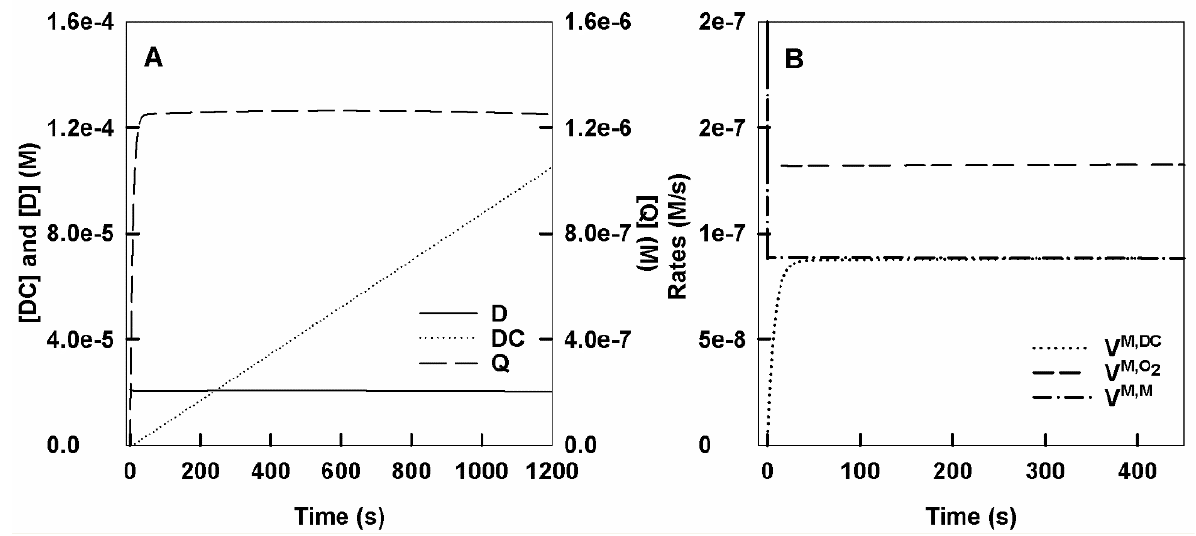
Figure 2. Simulated curves of the action of tyrosinase on L-tyrosine adding to the reaction medium the necessary concentra- tion of o -diphenol to reach steady-state. ( A ) Accumulation of DC, o -Q and D in the medium. ( B ) Relationship between the rates of M consumption (V M,M ), O 2 (V M,O 2 ) and DC formation rate (V M,DC ). The experimental conditions are the same than in Figure 1, but in this case, (cid:4670)D(cid:4671) (cid:2868) (cid:3404) 2.114 (cid:3400) 10 (cid:2879)(cid:2873) M .